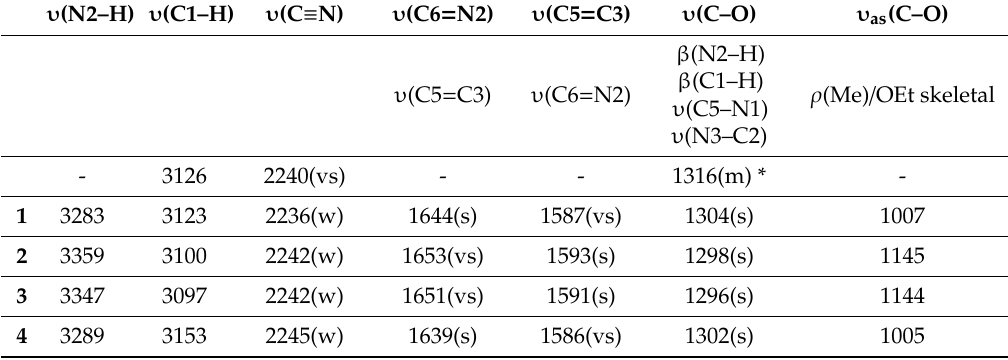
Table 3. The most important IR